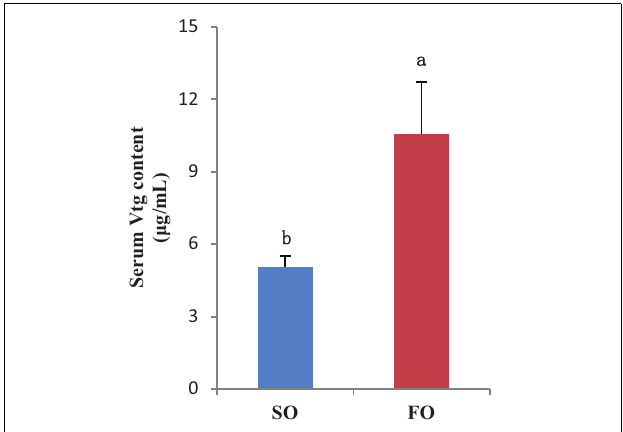
FIGURE 5 | Serum vitellogenin (Vtg) content of the female spotted scat fed with different oil sources ( µ g/ml, means ± SE, n = 10). Different letters denote statistically significant difference ( P <